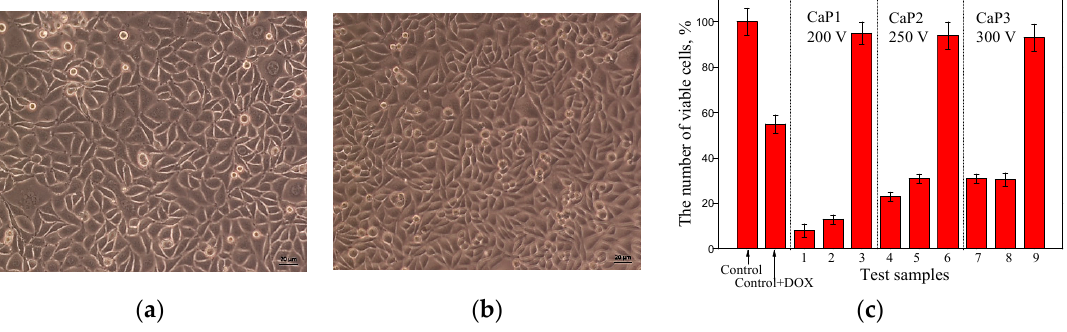
Figure 9. Photo of Neuro-2a cells in the control ( a ) and after incubation with a coating sample with DOX ( b ). Proliferation of tumor cells in the interaction with test samples of coatings ( c